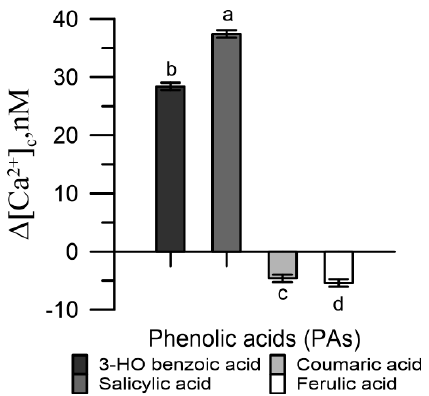
Figure 4. Activity of increasing doses (10–100 μ g) of emmer wheatgrass extracts extracted in methanol and resuspended in methanol (E M-M ) on the cytosolic Ca 2+ of maize pollen in the absence or presence of thapsigargin at 5 and 10 μ M. Data are expressed as means ± SEM from five independent tests. Different letters above bars indicate significant differences at p ≤ 0.05, whereas same letters indicate non-significant differences.